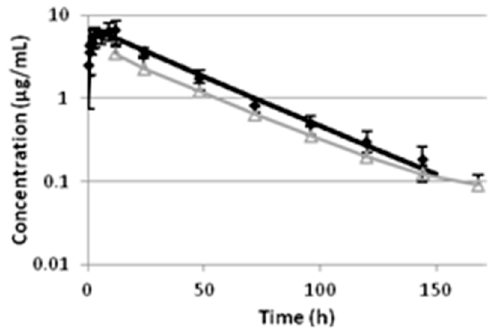
Figure 1. Semi-logarithmic mean ± SD plasma (predicted levels—black line and ♦ —observed concentrations) and milk (predicted levels—gray line and ∆ —observed concentrations) concentrations of oxytetracycline vs. time curve after a single intramuscular administration in cows ( n = 6) at a dose rate of 20 mg kg -1 . Table 2. Milk/plasma ratio (Mean ± SD) of oxytetracycline concentrations in cows ( n = 6) with clinical metritis after single intramuscular administration of 20 mg kg -1 oxytetracycline hydrochloride as a long-acting drug formulation.